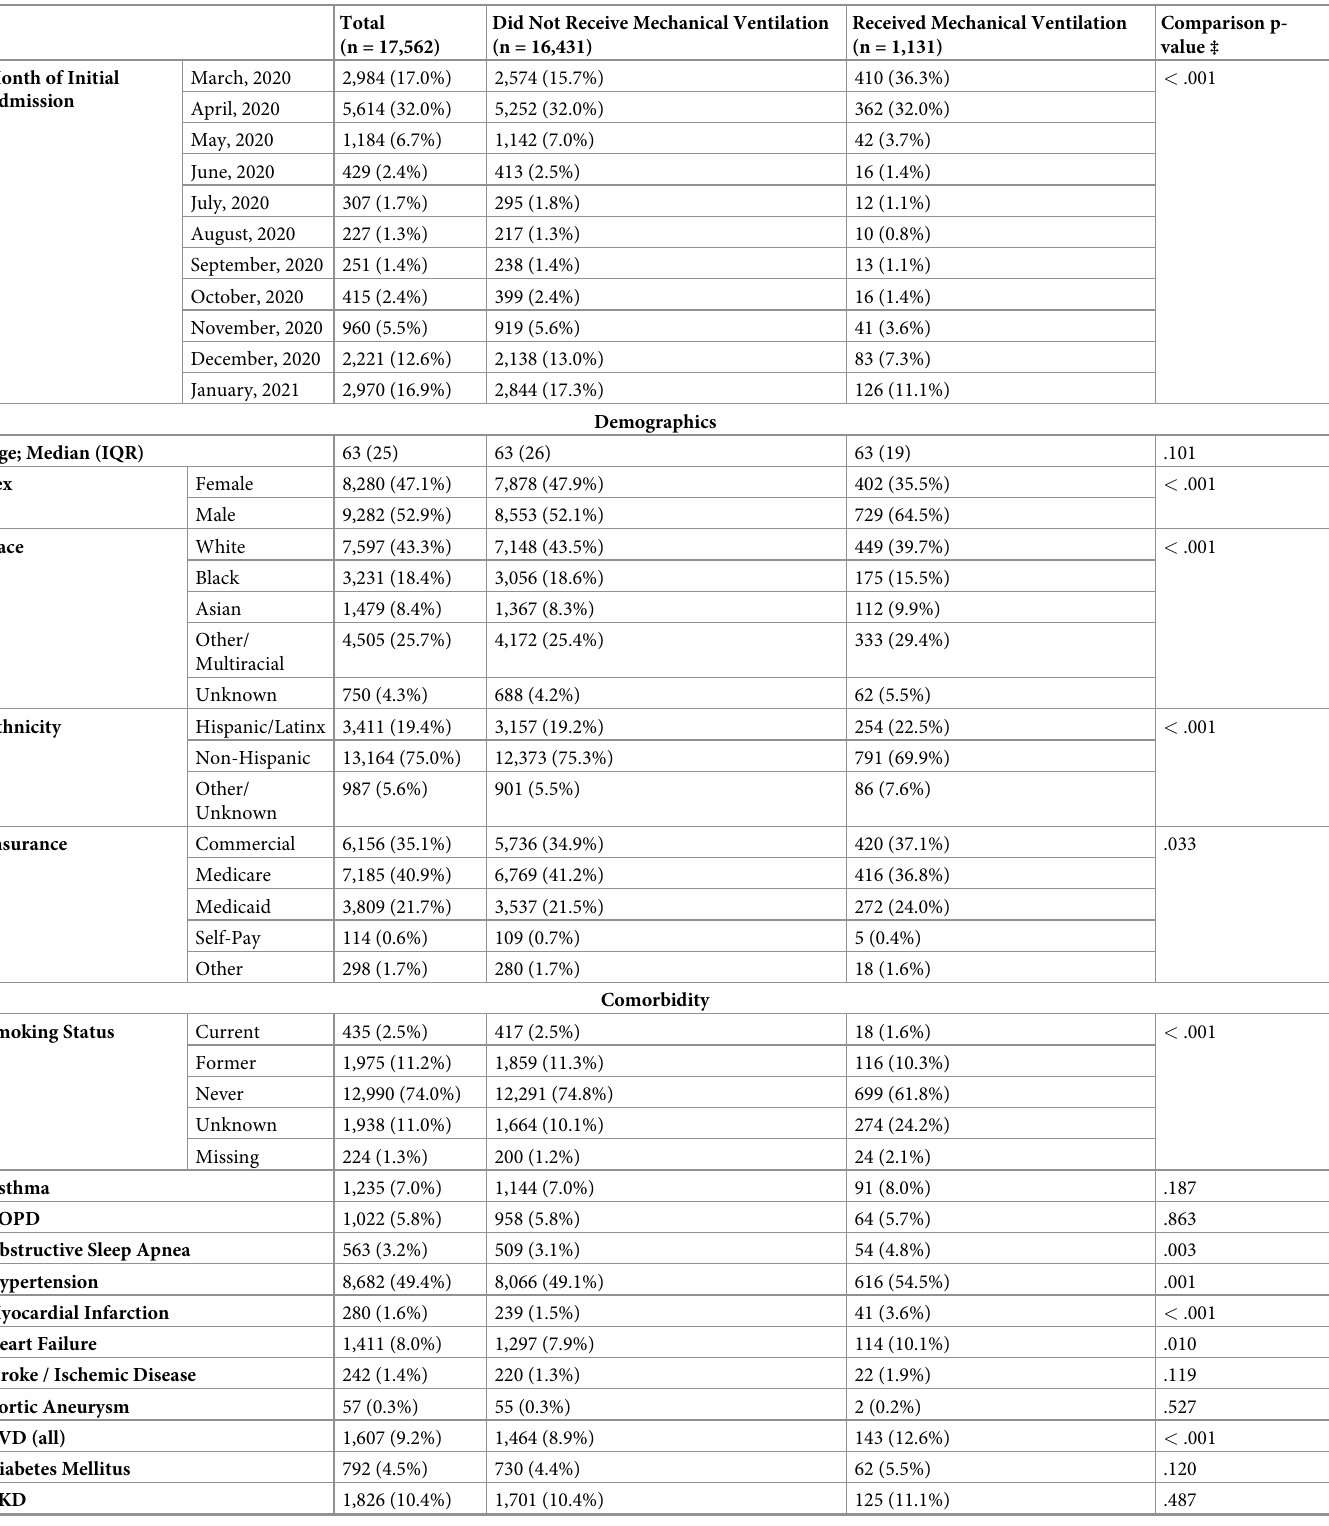
Table 1. Patient characteristics, comorbidity, visit details, anthropometric/laboratory values by mechanical ventilation status.